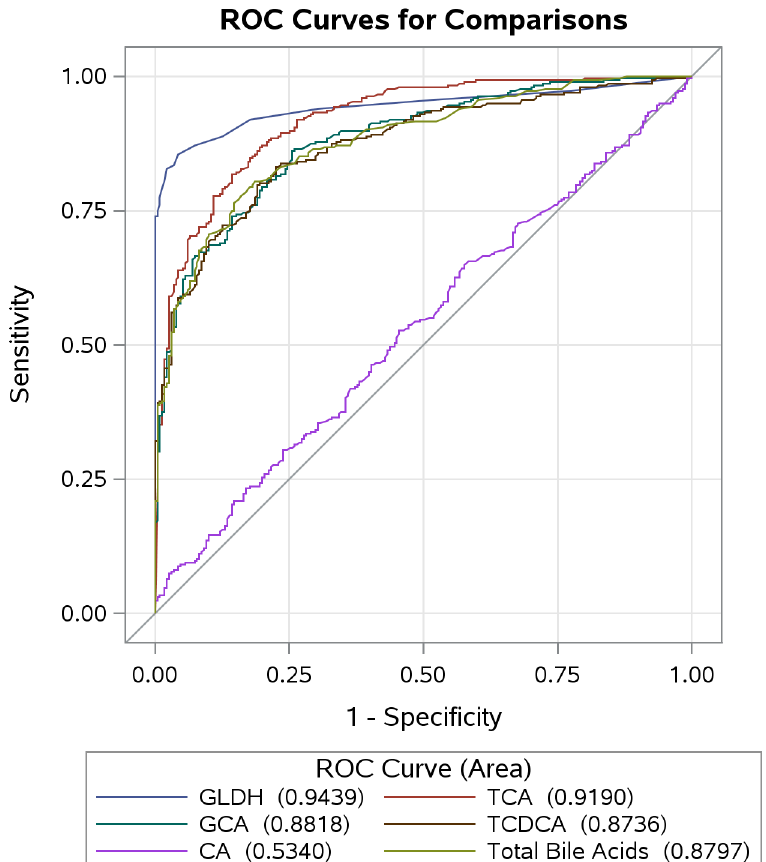
Fig 2. Receiver operating characteristic (ROC) curve for bile acids and liver injury. ROC curve analyses for 331 subjects evaluated the sensitivity and specificity of GLDH, TBA and IBA to detect liver injury. Liver injury was defined using a biochemical criterion [15] (b-id = "pxrfzr0 2x ALP or (cid:21) 3x ALT and (cid:21) 2x TBil). The values represented AUC for individual parameters.